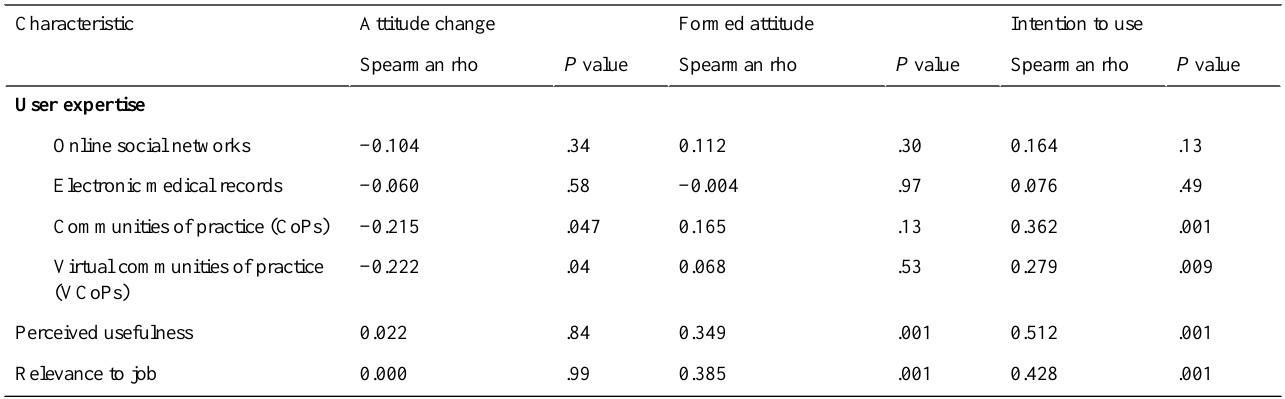
Table 2. Direct influence of user characteristic antecedents on outcomes (N=86).